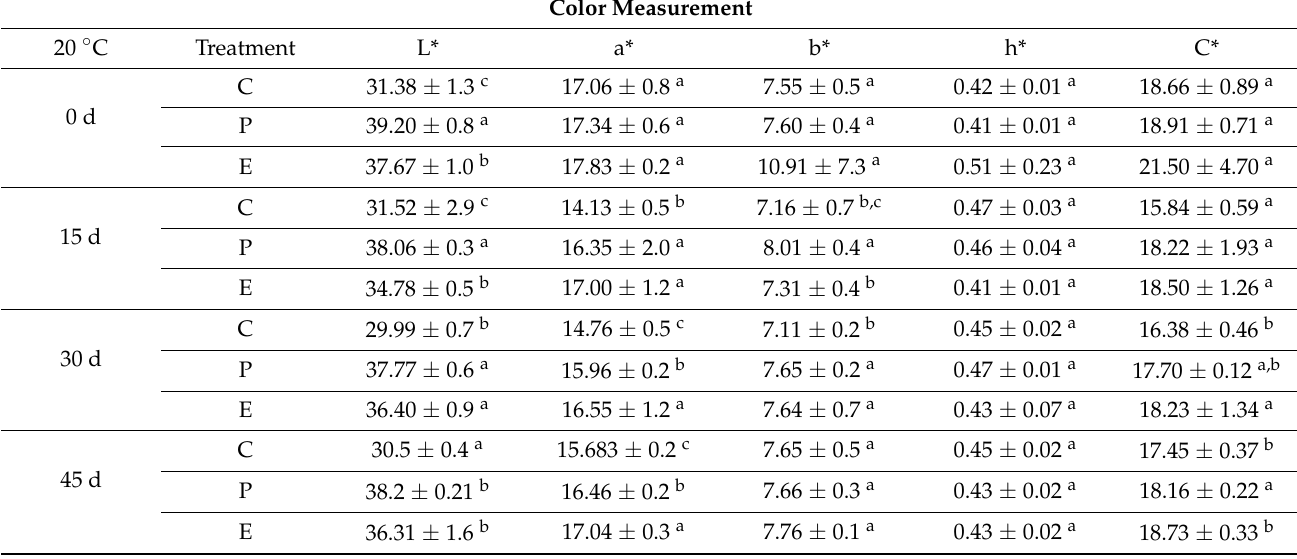
Table 1. Luminosity (L*), redness (a*), yellowness (b*), hue (h*), and Chroma (C*) (means ± standard deviations) of Salamines Criollos in the control group, in the free L. plantarum BFL treatment (P), and in the encapsulated L. plantarum BFL treatment (E) during 60 d of storage at 20 ◦ C and 5 ◦ C. Color